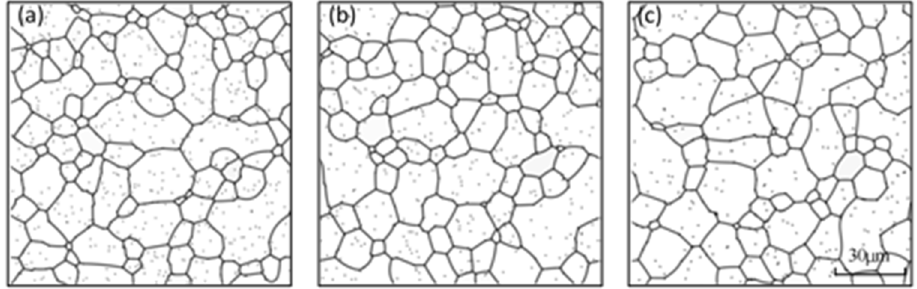
Figure 9. The simulation microstructure at 573 K after annealing for 30 min under a 135 MPa applied stress with a particle size: ( a ) 0.3 μm; ( b ) 0.45 μm; and ( c ) 0.6 μm.